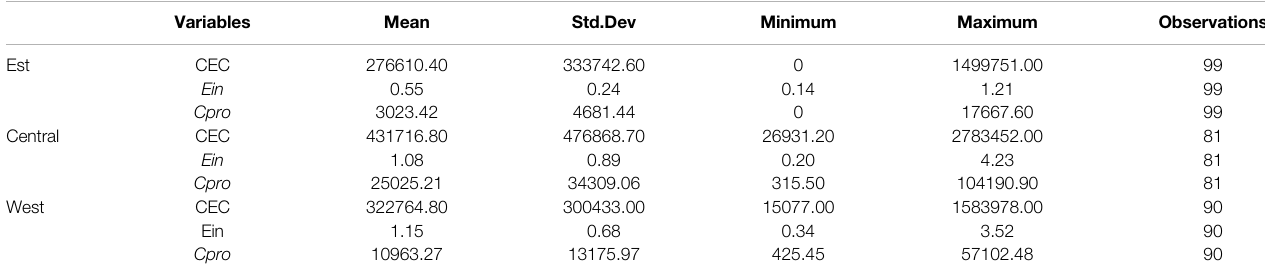
TABLE 10 | Statistical properties of CEC, Ein , and Cpro in different regions. Variables